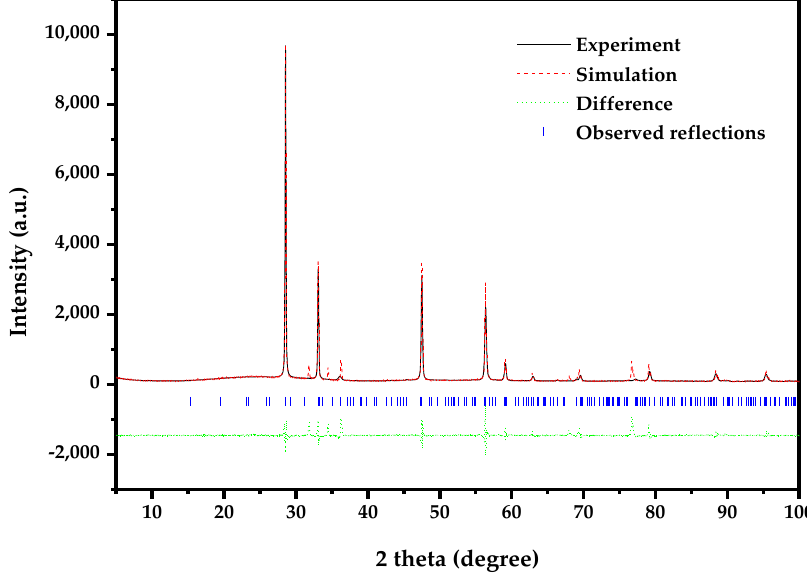
Figure 6. Pawley refinements of XRD data for novel photocatalyst ZnBiErO 4 prepared by the solid-state reaction method at 1000 °C. The solid line represents experimental X-ray diffraction pattern. The dot line represents simulation X-ray diffraction pattern. The tic marks represent reflection position. A difference between observed and calculated profile is shown beneath.